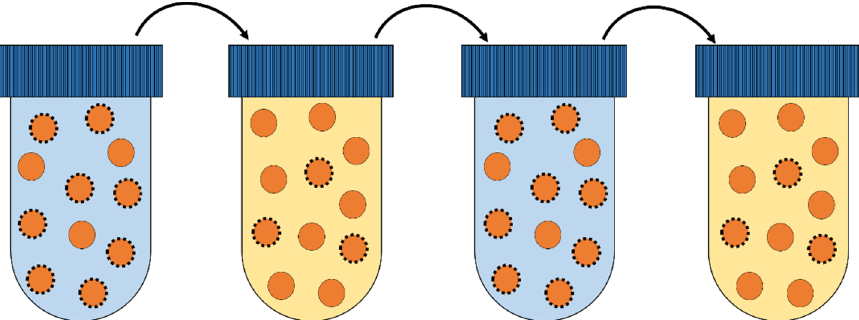
Figure 7. Cells with the same genotype can adapt to changing environments (different colour of tube content), by random switches between phenotypic states (dashed or non-dashed edges of cells). Phenotypic heterogeneity of a population of cells can allow quick resumption of growth upon a switch in the environment, as a subpopulation will be “preadapted” to the new